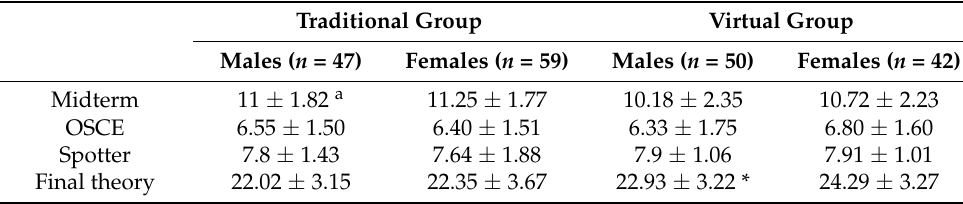
Table 6. Comparison between male and female performance in course tests among the